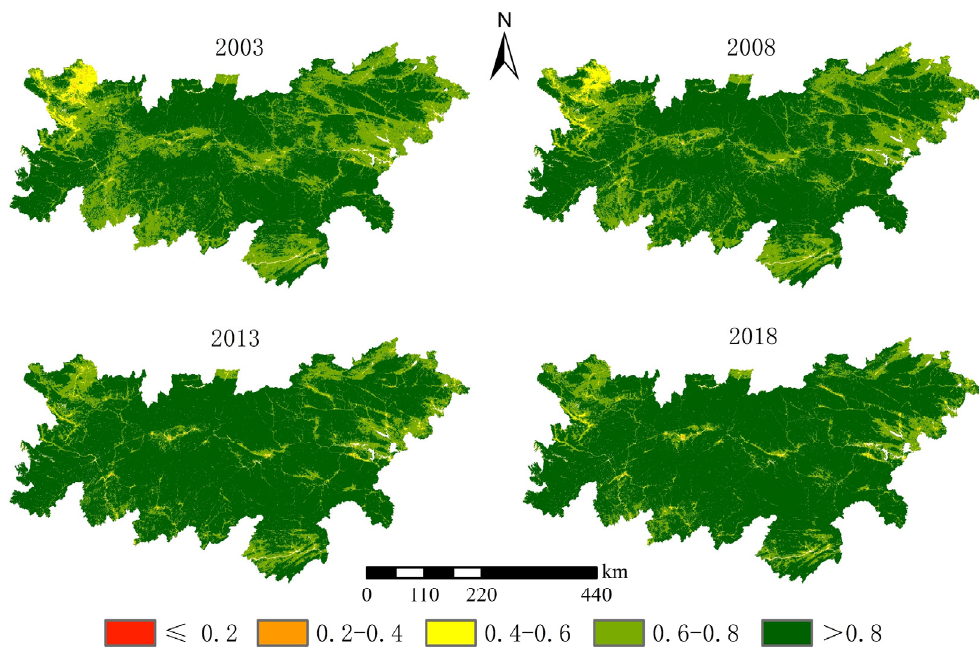
Figure 5. Spatial pattern of NDVI in the QBM,